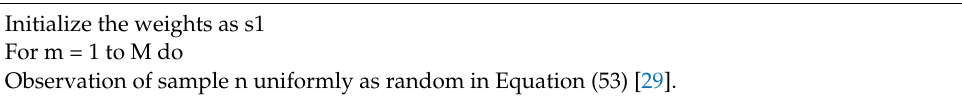
Algorithm 2 : Complexity Computation